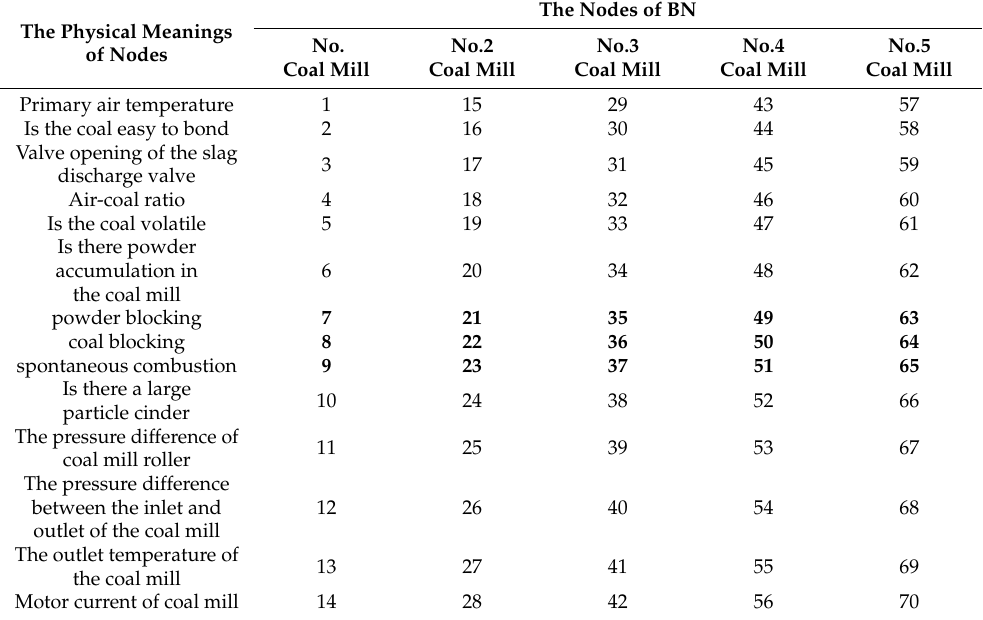
Table 6. Physical meanings and the grades of